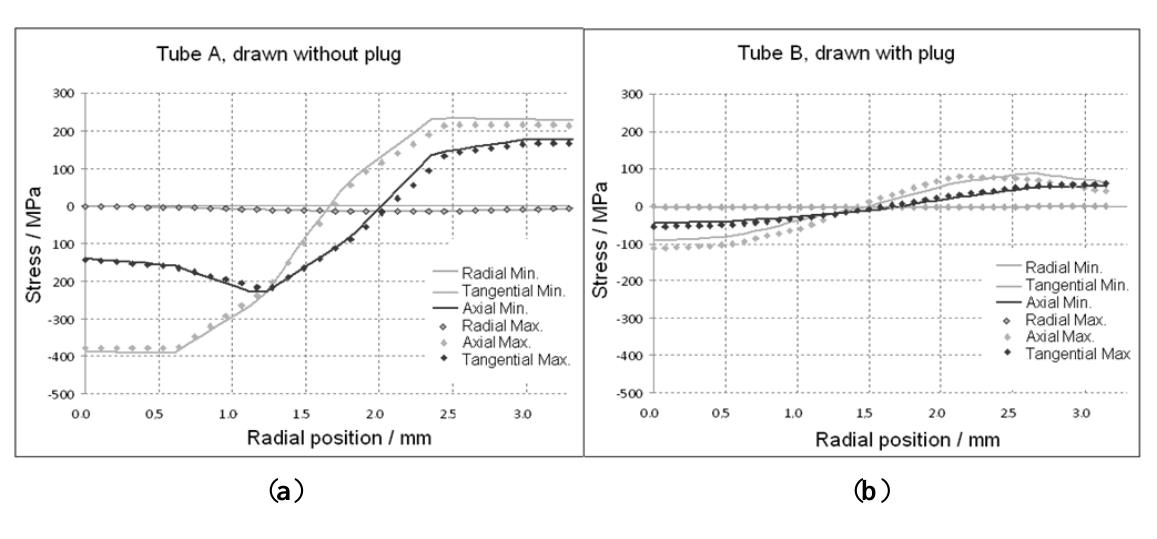
Figure 9. Simulated residual stresses in the position of minimum and maximum wall